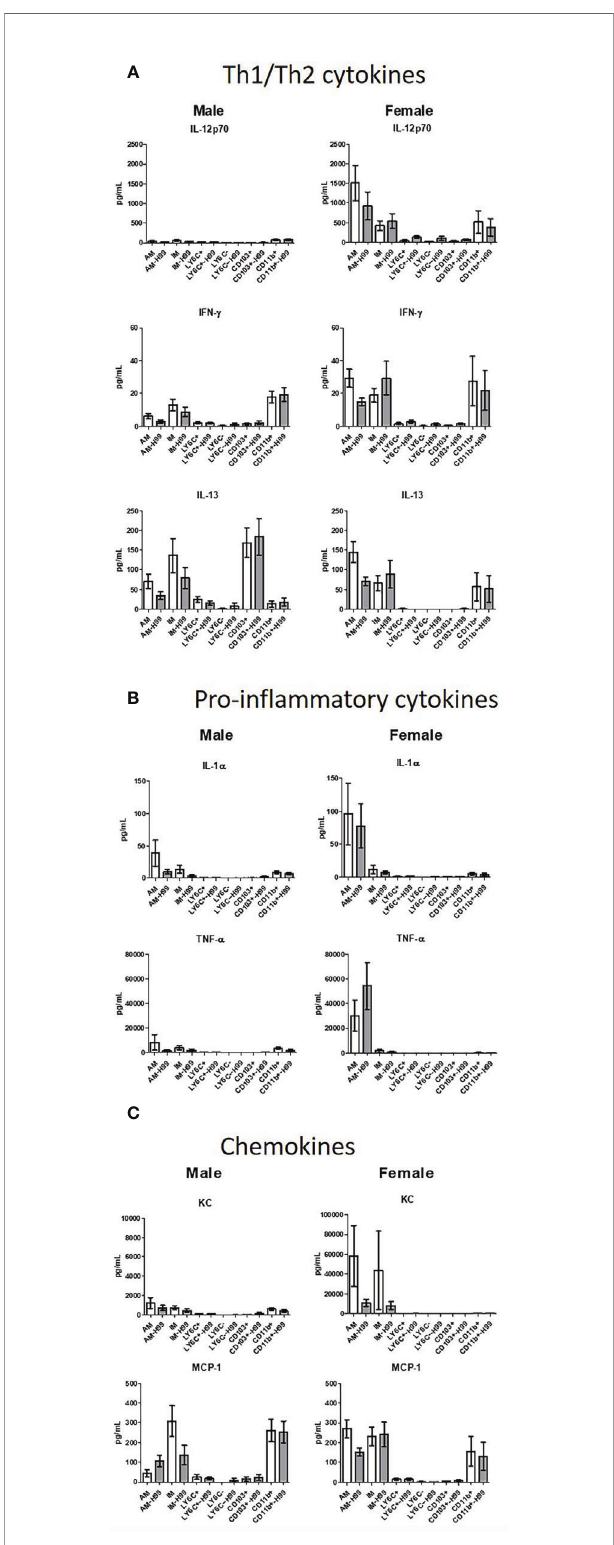
FIGURE 5 | Pulmonary phagocyte cytokine production following incubation with C. neoformans . Murine pulmonary macrophages and DCs were harvested from pooled tissues from 20 mice/experiment and puri fi ed using magnetic separation. Cell subsets were incubated at a 20:1 ratio with C. neoformans for 2h at 37°C, 5% CO 2 then supernatants were collected. Samples were treated with protease inhibitor and frozen at -80°C until analysis. Samples were analyzed for cytokines/chemokines by Bioplex (BioRad). (A) Th1/Th2 cytokine secretion in pg/ml from both male and female phagocyte subsets alone (clear bars) and when incubated with C. neoformans strain H99 (gray bars). (B) Pro-in fl ammatory cytokine secretion in pg/ml from both male and female phagocyte subsets alone (clear bars) and when incubated with C. neoformans strain H99 (gray bars). (C) Chemokine secretion from both male and female phagocyte subsets alone (clear bars) and when incubated with C. neoformans strain H99 (gray bars). Data are shown as pg/ml ± standard errors of the means (SEM) from 3 independent experiments each from male mice and female mice (n=3 experiments in each male and female mice). AM = alveolar macrophages, M = interstitial macrophages, LY6N = Ly6c negative monocyte-like macrophages, LY6P= Ly6c positive monocyte-like macrophages, CD11b = CD11b + dendritic cells, CD103 = CD103 +